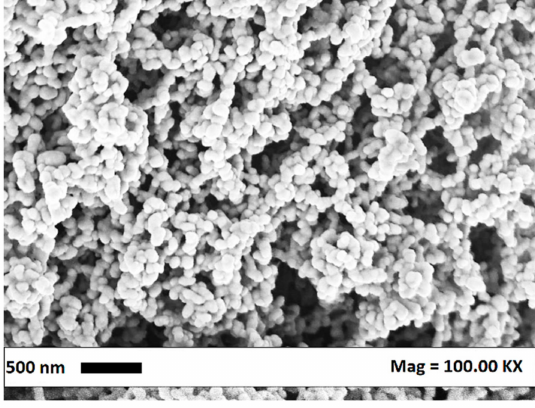
Figure 2. CA nanoparticles obtained at 15 MPa, 60 ◦ C and 15 mg / mL.